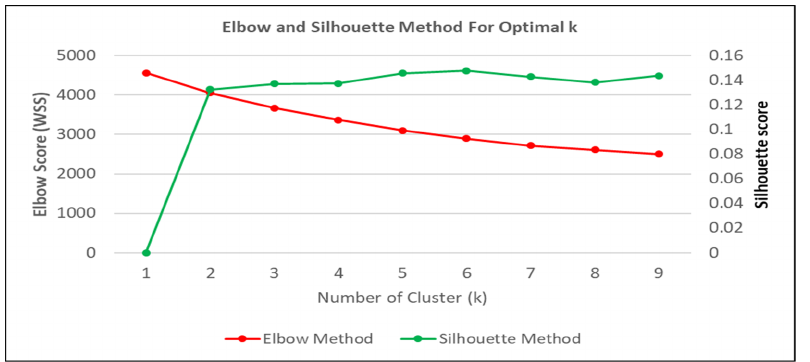
Figure 2. Optimal Number of Clusters .